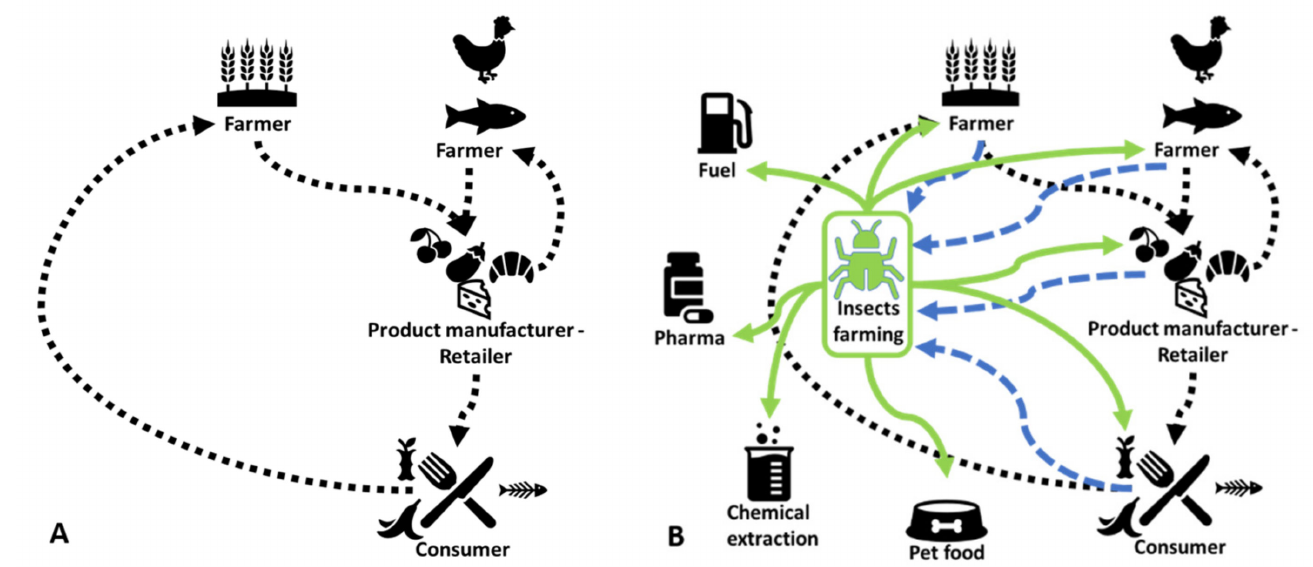
Figure 1. Enhancing of Circular Economy via insects farming. ( A ) and ( B ) represents the strengthening of the circular economy via edible insect